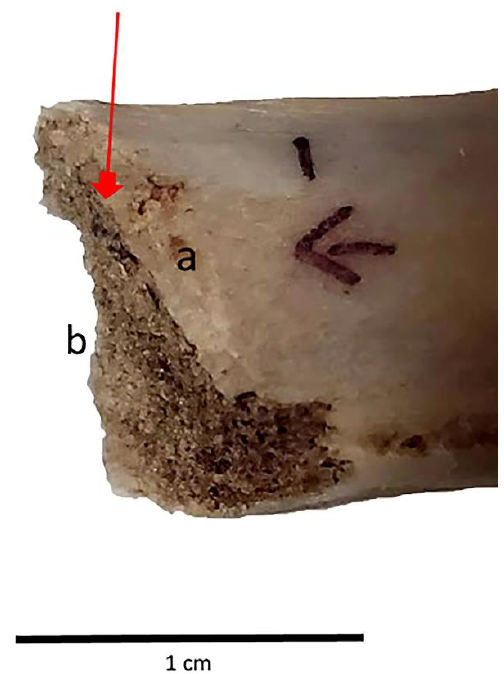
Figure 6. Class 3 experimental chop mark made by the bronze axe on a pig rib (cBI 13); (a) light crushing at place of impact (arrow indicates the place and direction of the impact), and (b) controlled breakage.